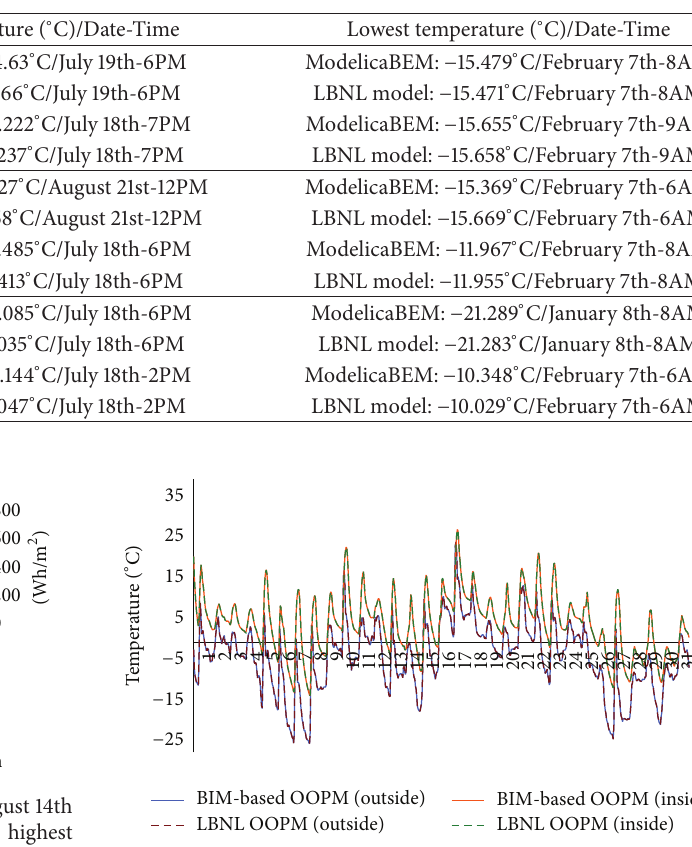
Figure 15: Temperature comparison between the two models for the east wall in Test Case 2 during January.